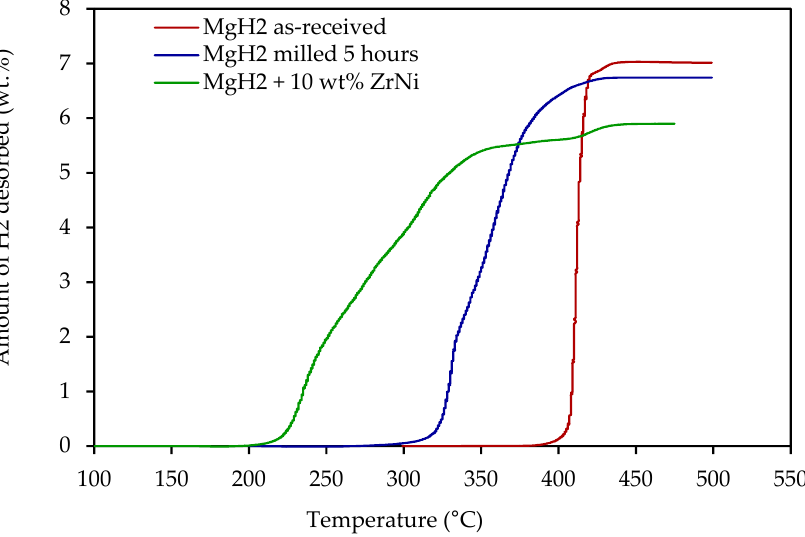
Figure 4. Thermally programmed H 2 desorption capacity curves of studied powders. Same experimental conditions as given in Figure